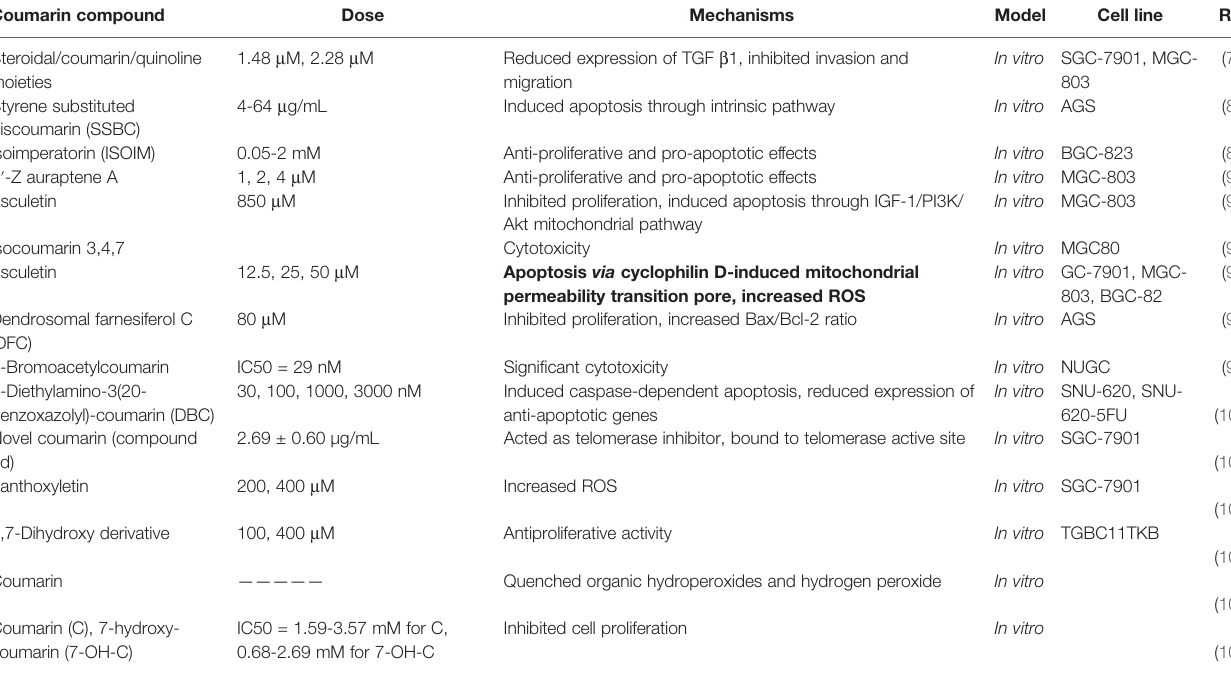
TABLE 1 | Anti-gastric cancer effects of